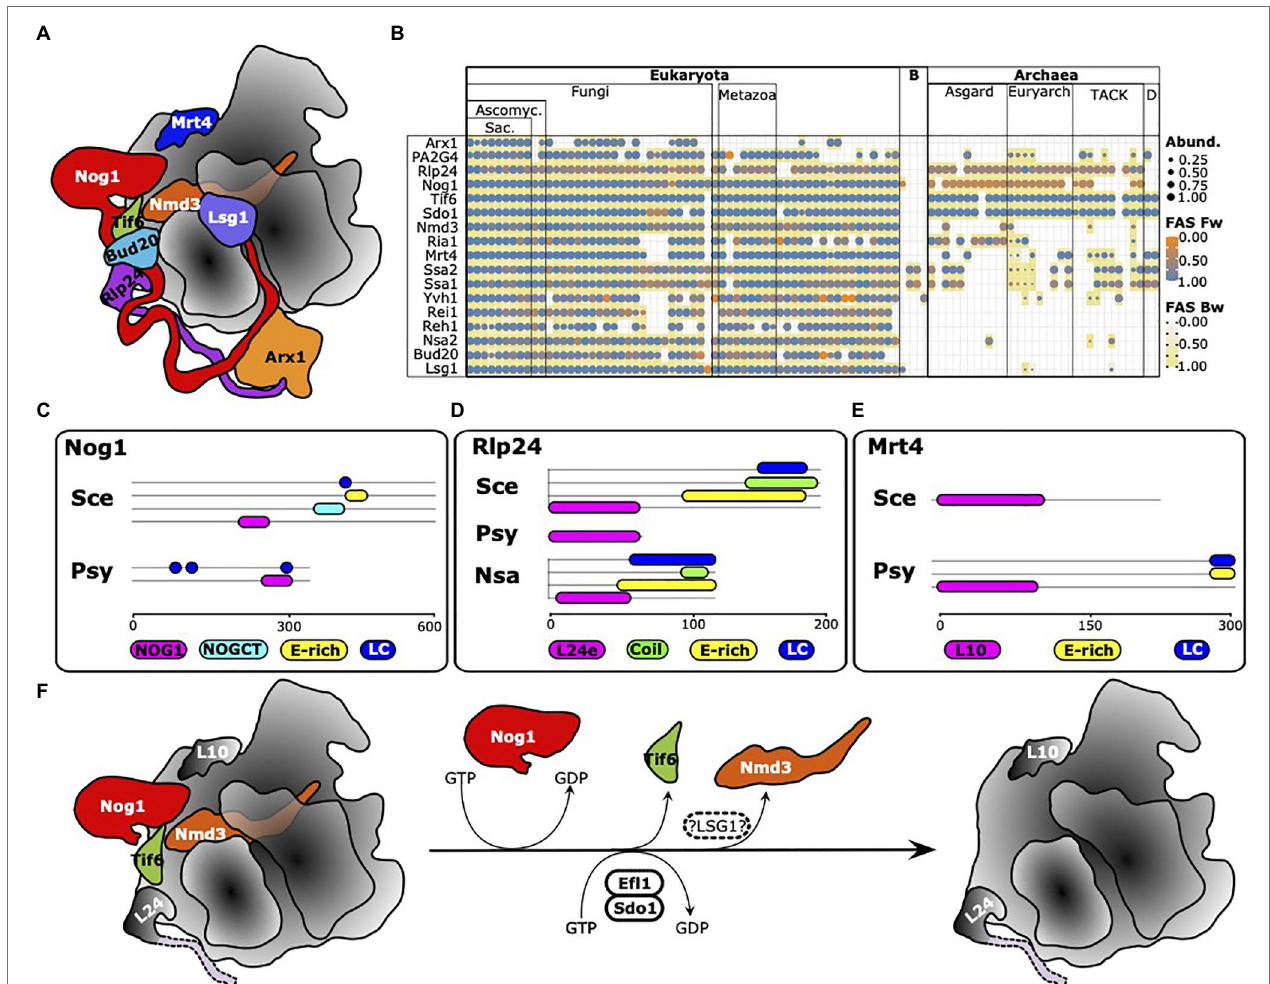
FIGURE 8 | Maturation of the large ribosomal subunit in archaea is a simplified version of the process in eukaryotes. (A) Ribosome biogenesis factors involved in eukaryotic pre-60S maturation. Figure re-drawn from Klingauf-Nerurkar et al. (2020). (B) Phylogenetic profiles of the factors involved in yeast 60S maturation. PA2G4 is a human functional equivalent to Arx1 in yeast (see text for details). (C-E) Domain architectures of yeast Nog1, Rlp24, and Mrt4 and of a representative archaean ortholog. Sce, S. cerevisiae ; Psy, Prometheoarchaeum syntrophicum ; and Nsa, Natronomonas salsuginis . Protein ids: Nog1 Sce – Q02892; Nog1 Psyn – WP_147661298; Mrt4 Sce – P33201; Mrt4 Psyn – WP_147662854; Rlp24 Sce – Q07915; Rlp24 Psyn – WP_147664435; and Rlp24 Nsa – WP_137275029. (F) Essential steps of large subunit maturation likely to be conserved between eukaryotes and archaea. Thus far, we have no evidence for the presence of LSG1 in archaea (hatched